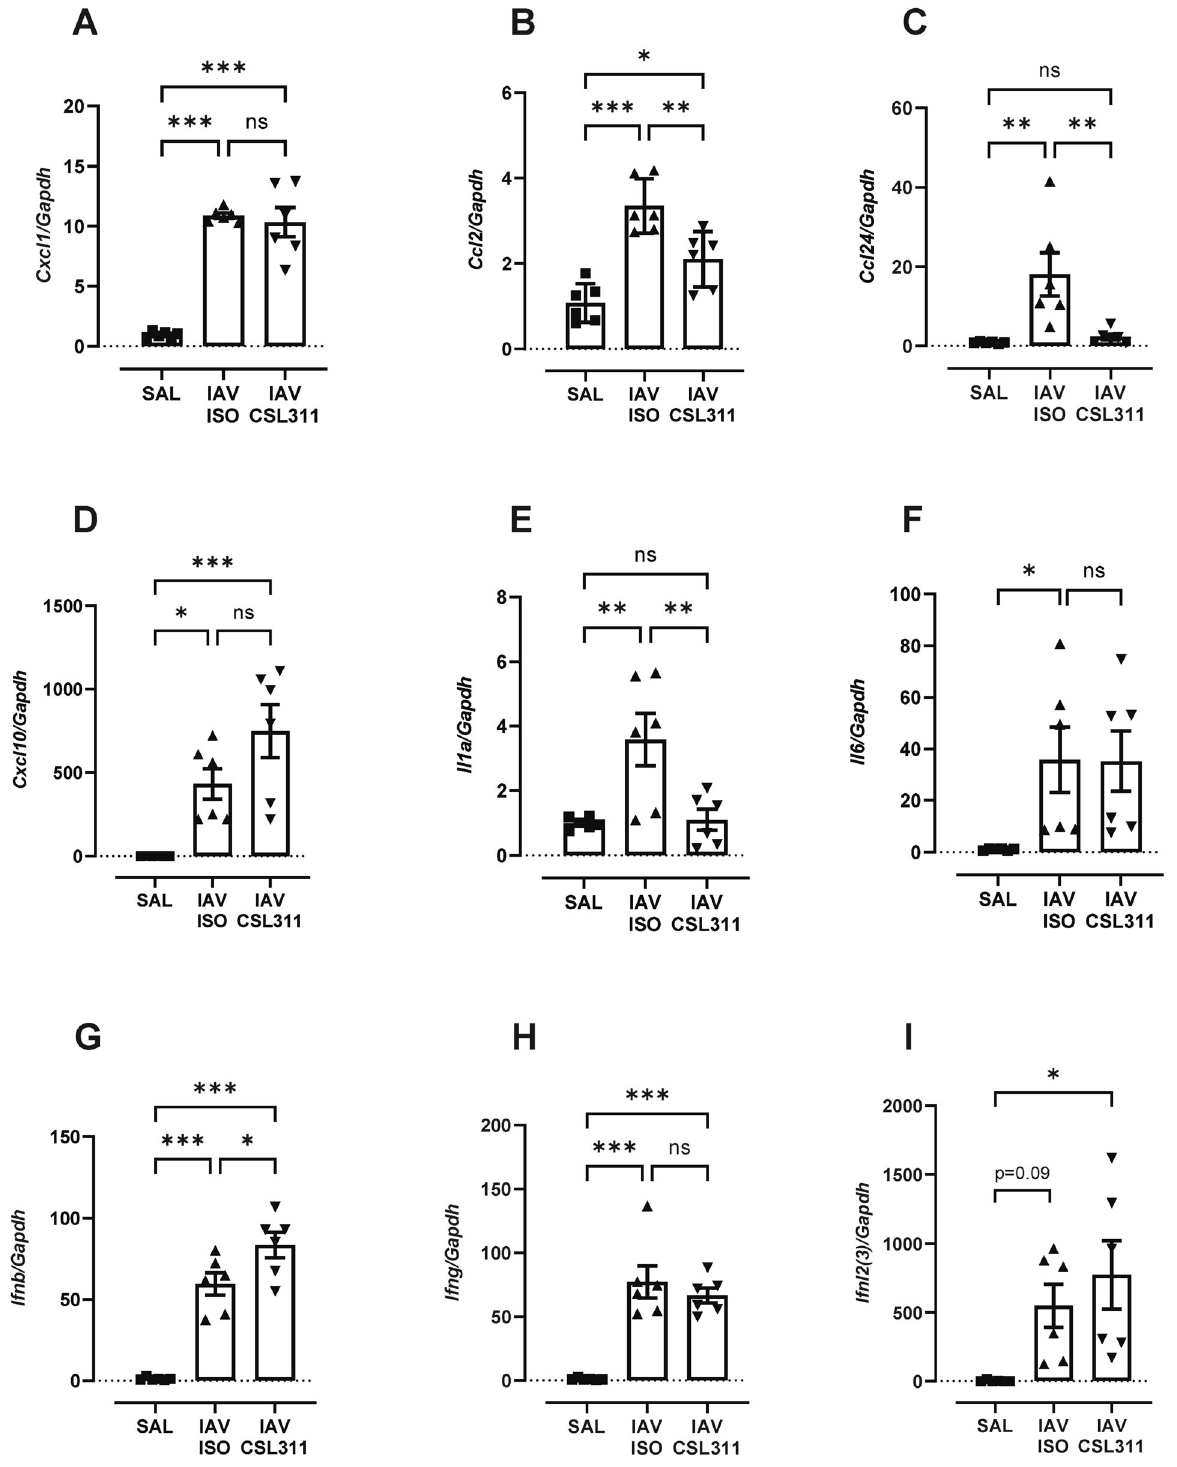
Fig. 8 CSL311 attenuates lung cytokine storm and preserves interferon expressions in IAV-infected h β c Tg mice. Expression of the neutrophil chemokine ( A ) Cxcl1 , monocyte/macrophage chemokine ( B ) Ccl2 , eosinophil chemokine ( C ) Ccl24 , T cell/NK cell chemokine ( D ) Cxcl10 were detected by RTqPCR in the lungs of IAV-infected mice, where CSL311 signi fi cantly lowered Ccl2 and Ccl24 levels. Expression of the pro-in fl ammatory genes ( E ) Il1a and ( F ) Il6 were also increased in IAV-infected mice and CSL311 treatment signi fi cantly reduced Il1a but not Il6 expression. G Type I interferon ( Ifnb ), ( H ) type II interferon ( Ifng ) and ( I ) type III interferon ( Ifnl2/3 ) were also markedly induced in the lungs of IAV-infected mice in a manner that was not signi fi cantly altered by CSL311 treatment; n = 6; * p < 0.05, data are Mean ± SE; ** p < 0.01, *** p < 0.001 one-way